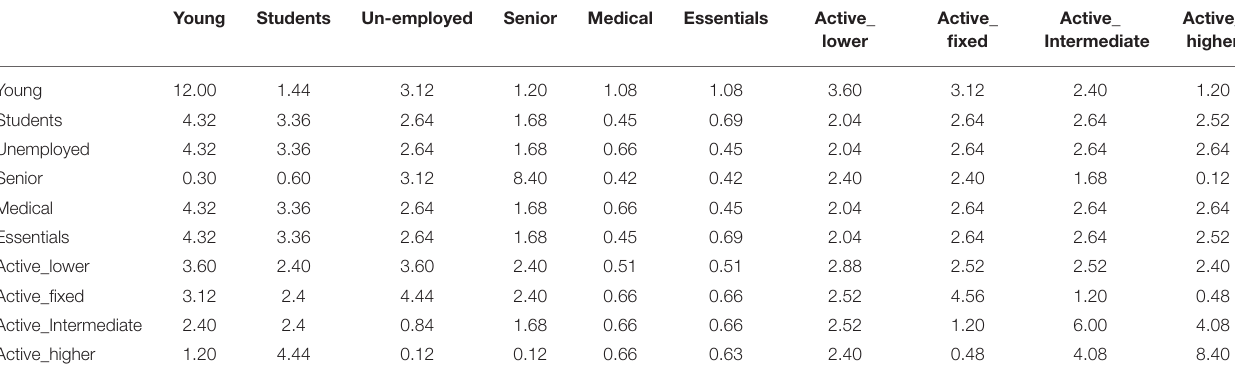
TABLE 3 | Parameters, values, and sources to define the bioeconomic model.